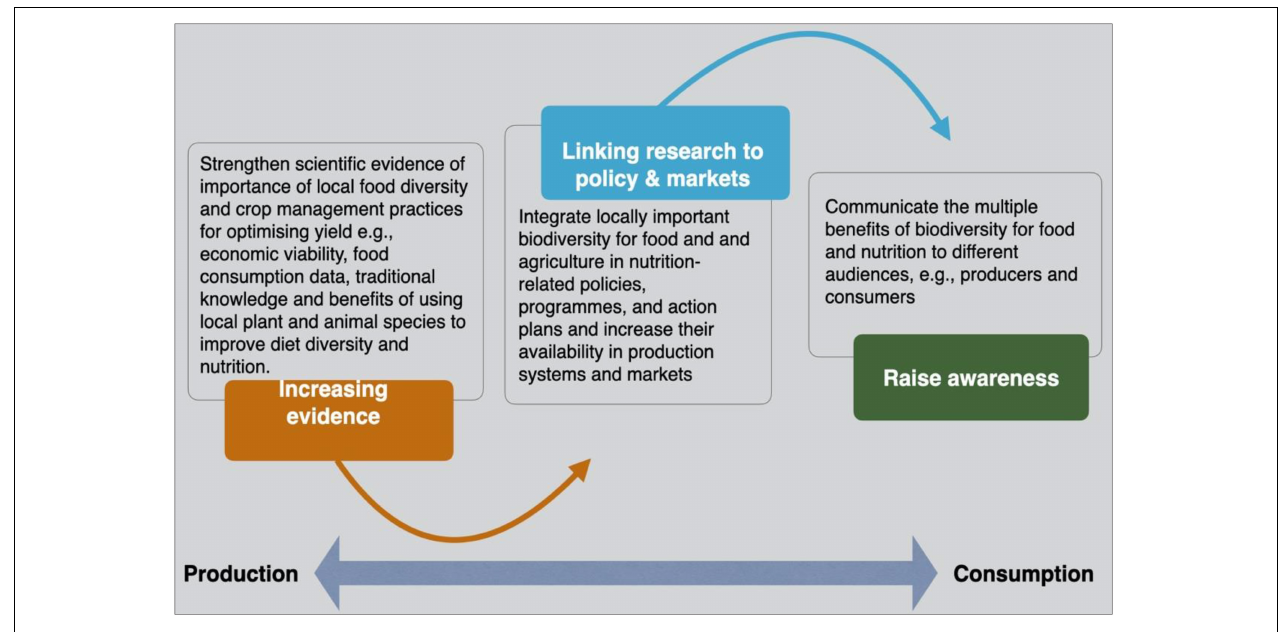
FIGURE 1 | A three-pronged approach for mainstreaming underused and neglected crops. Source: Adopted from Borelli et al.